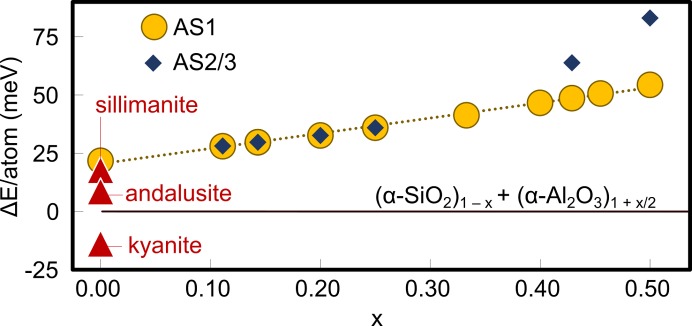
Comparison of calculated total energies (PBEsol-D) of aluminium silicates with total energies of a hypothetical system where the atoms form respective amounts of α-SiO2 and α-Al2O3.